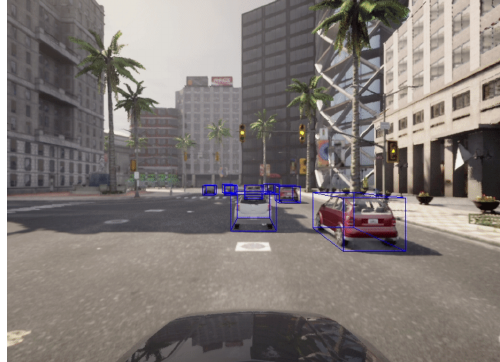
Figure 12. Carla example with projected bounding